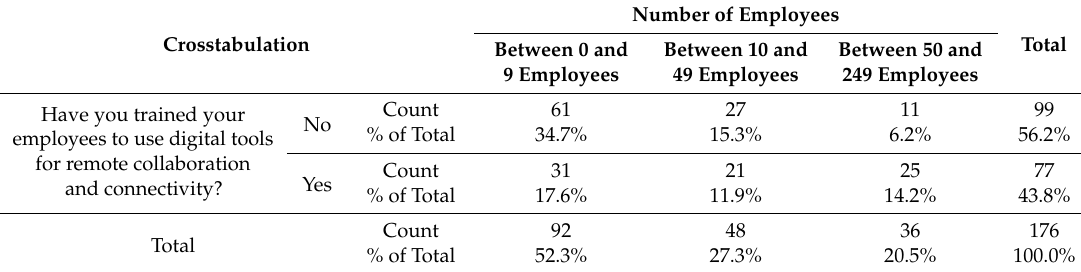
Table 10. The contingency table on the extent to which SMEs train their own employees in digitization in relation to the size of the enterprise.